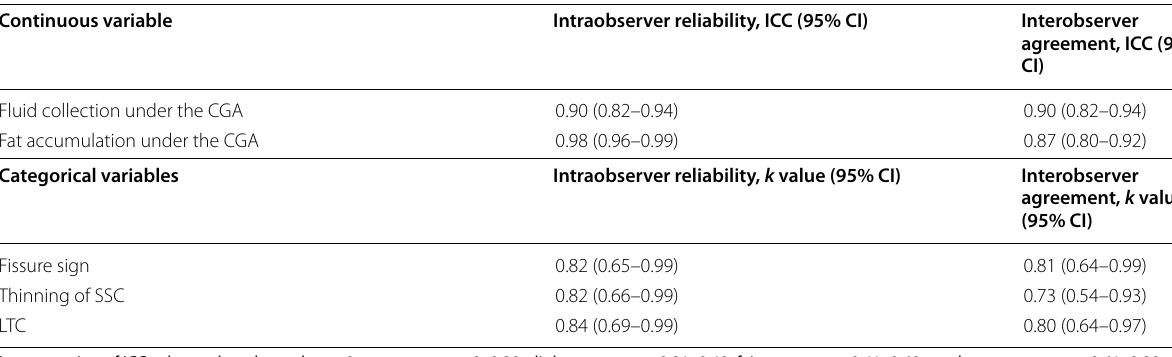
Table 2 Intraobserver reliability and interobserver agreement for the associated imaging